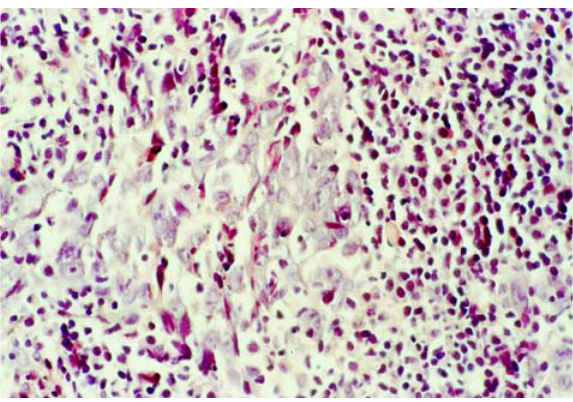
Figure 2 – Renal cell carcinoma with a trabecular and alveolar pattern (HE, X10).